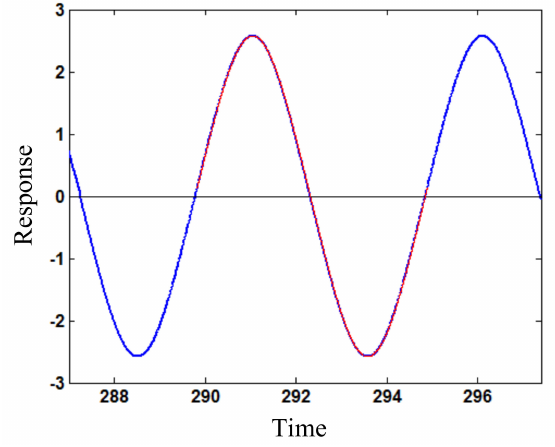
Figure 5. Stationary larger-amplitude response ( w ) varying with time ( t ) for loading frequency ω = 1.24 (blue solid line: numerical simulation; red dotted line: the developed method).